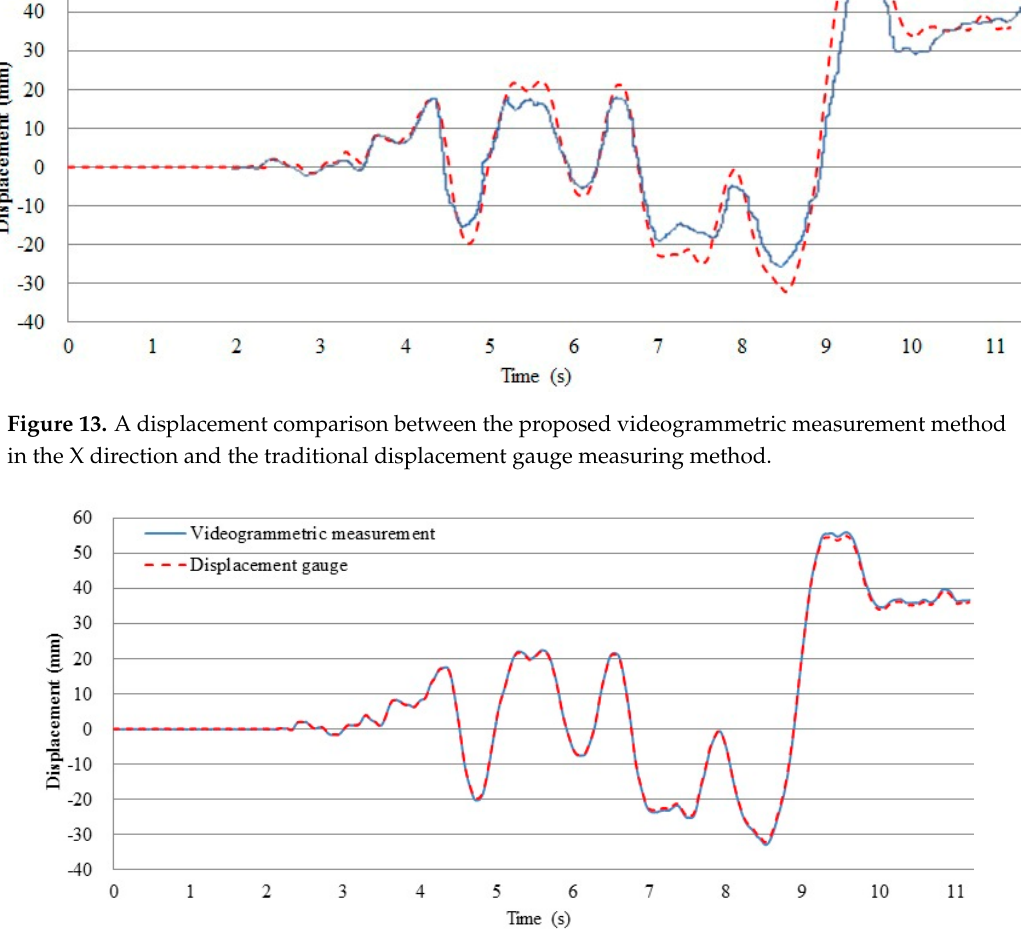
Figure 14. The curves of displacement changes from displacement gauge and Euclidean displacement by the videogrammetric measurement.